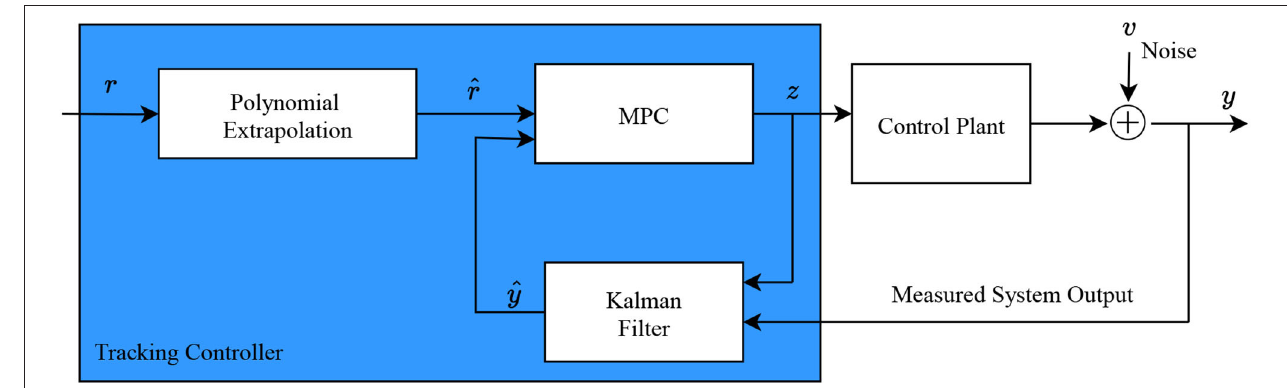
FIGURE 1 | Architecture of the proposed tracking